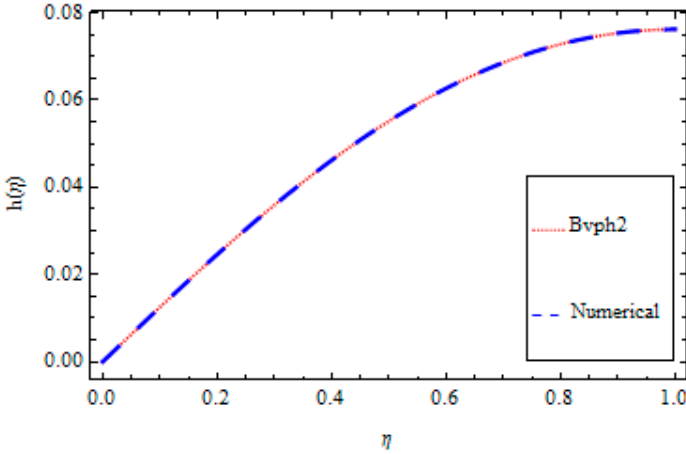
Figure 5. Graphical comparison of the HAM and numerical solution.